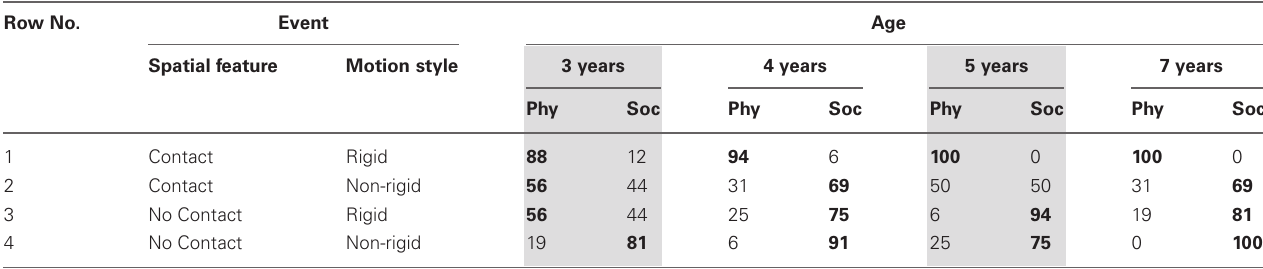
Table 1 | Percentage of physically and socially causal attributions, in 4 age groups, for launch events with contact and reaction events without, each involving rigid, inanimate, or non-rigid, animate motion in Experiment 1. Row